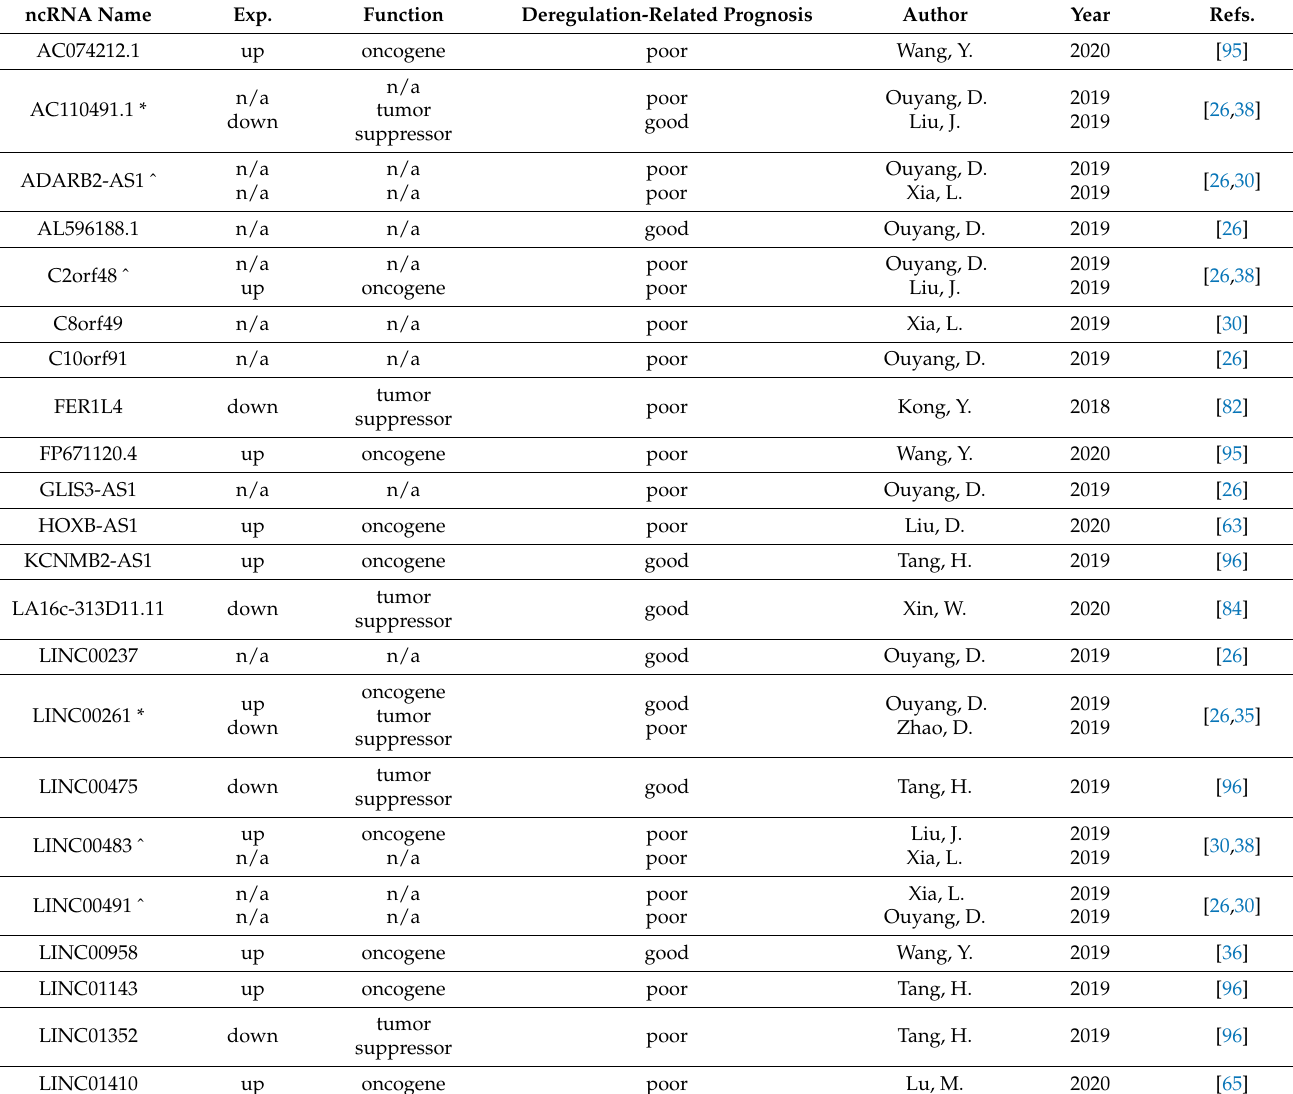
Table 5. A summary of ncRNAs that play a role in EC